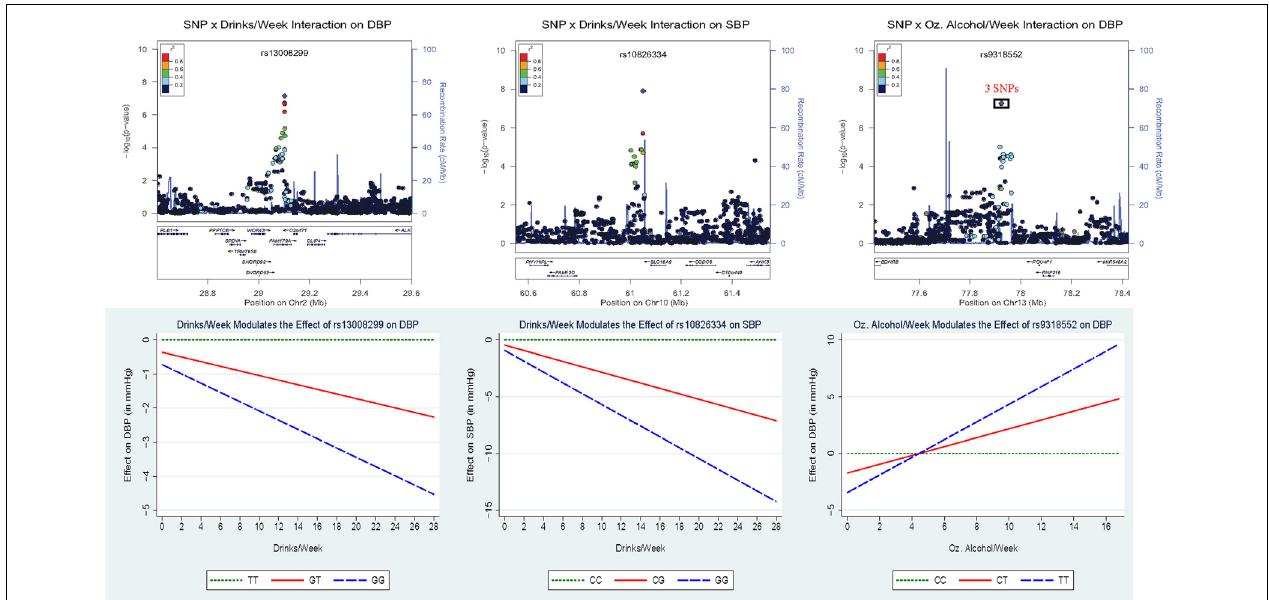
FIGURE 2 | Regional association plots for the three loci with the strongest statistical evidence, as well as plots of the effect of the index SNP as a function of alcohol consumption. In the top panel , the p -value of the 2df test is plotted vs. the chromosomal location (in basepairs) with the color scheme indicating the degree of linkage